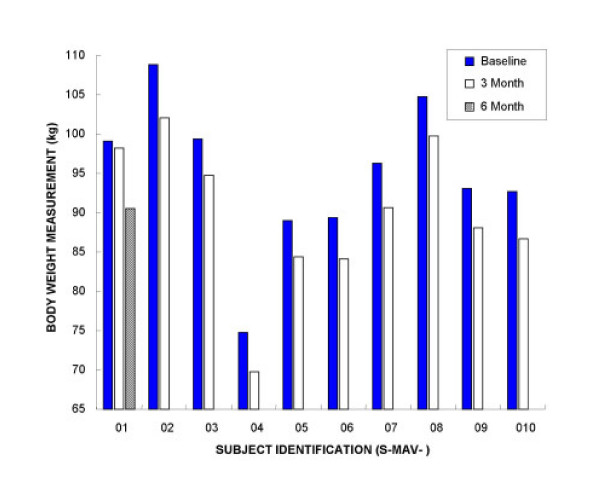
Individual body weight loss in 10 obese participants at Initial session and 3 mo following a commercial regimen (Minçavi®). Mean group body weight loss showed a statistically significant decrease (Initial session 94.7 +/- 3.0; 3 mo 89.9 +/- 3.0 kg; Student's paired t = 9.90; p < 0.0001; two tailed). The range of body weight loss was from 0.9 kg to 6.8 kg for all participants who followed the Minçavi® diet for three months. One participant (ID. S-MAV-01) was invited to return for a follow-up visit after 6 mo on diet. Her body weight showed a continued decrease of 0.9 kg at 3 mo and 8.6 kg at 6 mo.